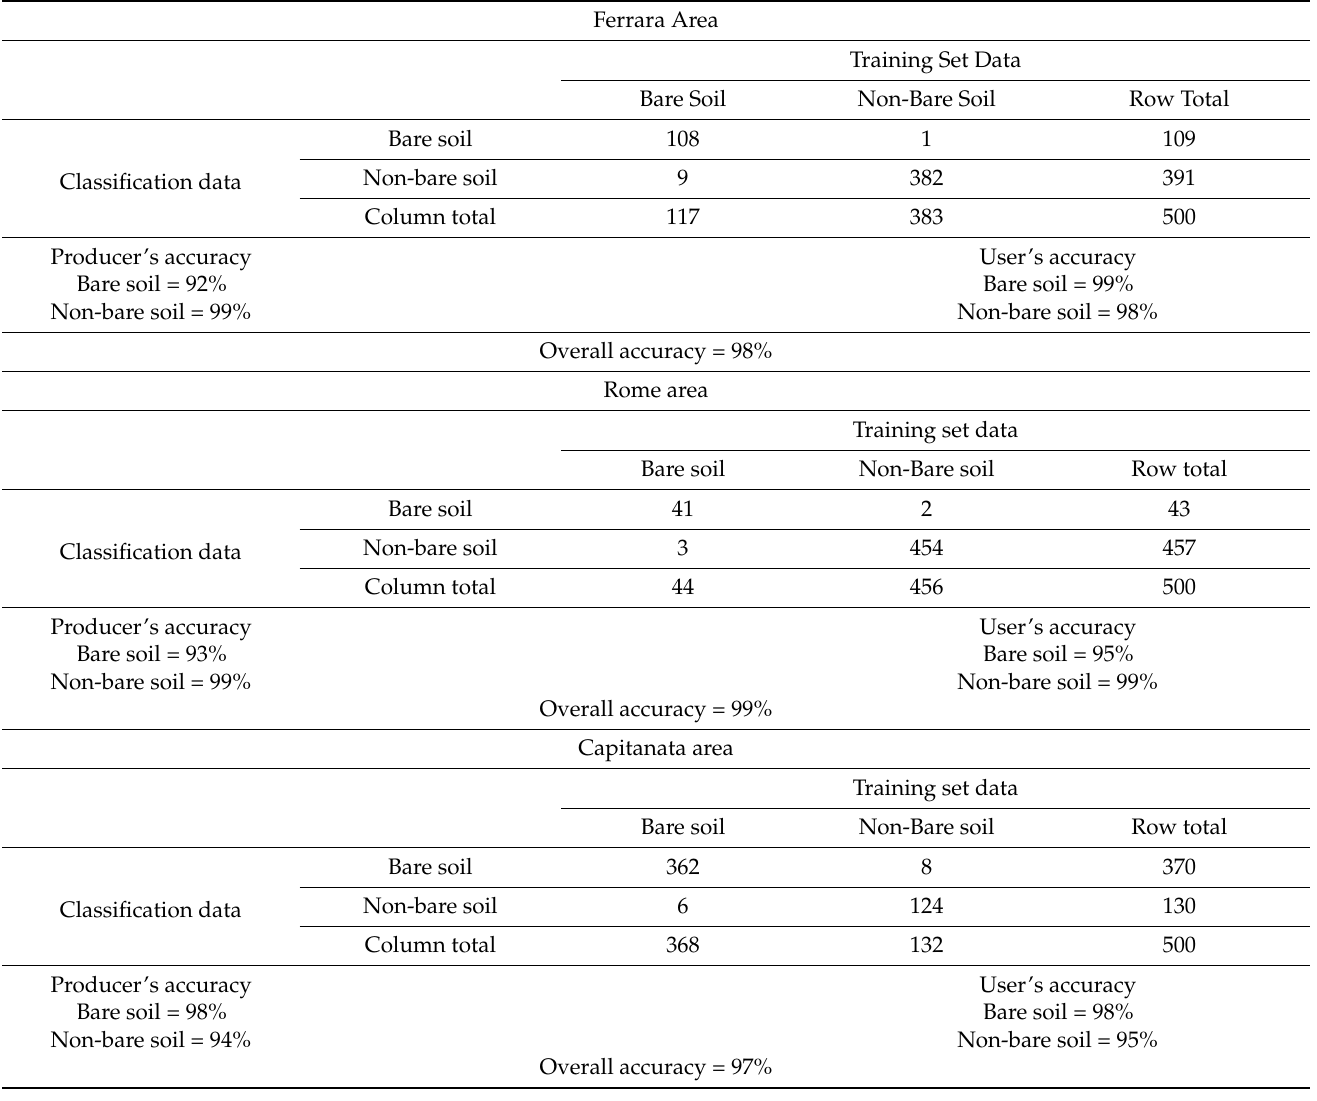
Table 3. Error matrix generated from a classification of the training set pixels over the study